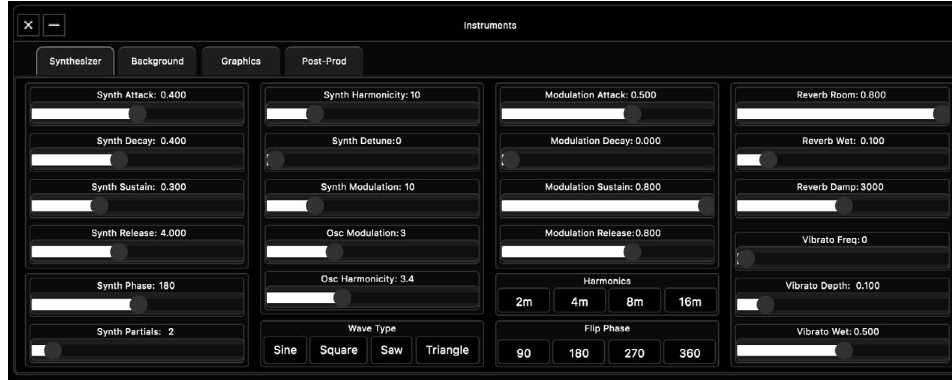
Figure 5: GUI Elements of Akson: 4) Instruments Dialog – Lead tab.